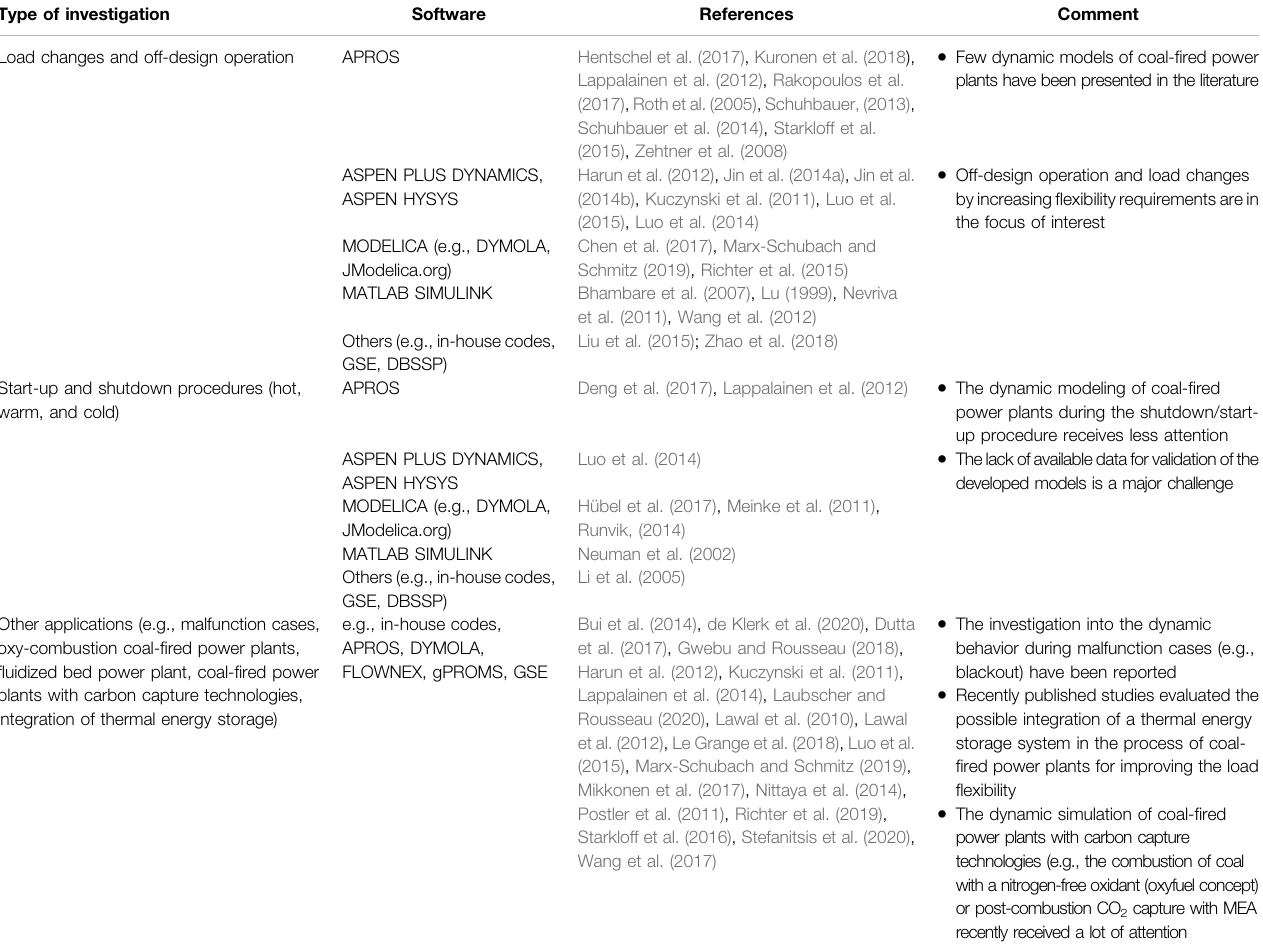
TABLE 5 | Overview of dynamic simulation studies applied to coal- fi red power